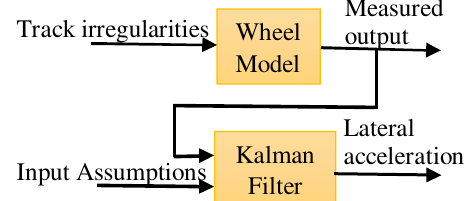
Fig. 3: Railway Vehicle Condition